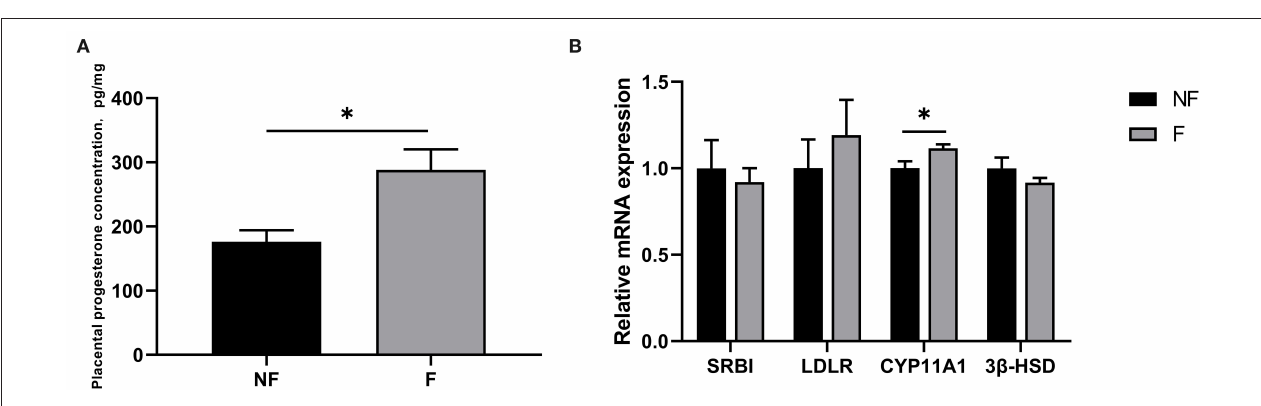
FIGURE 5 | Effects of fiber supplementation in gestation diet on progesterone concentration and gene expressions related to progesterone synthesis in sow placenta. (A) Progesterone concentration; (B) Gene expressions of scavenger receptor BI (SRBI), low-density lipoprotein receptor (LDLR), cytochrome P450 11A1 (CYP11A1), and 3 β -hydroxysteroid dehydrogenase/isomerase (3 β -HSD). NF, sows fed with a semi-purified basal diet (0.01% dietary fiber); F, sows fed with a semi-purified basal diet supplemented with 8.33 g/kg inulin and 200 g/kg cellulose. Values are mean ± standard error ( n = 5). Significant differences are displayed in the figures by * P <